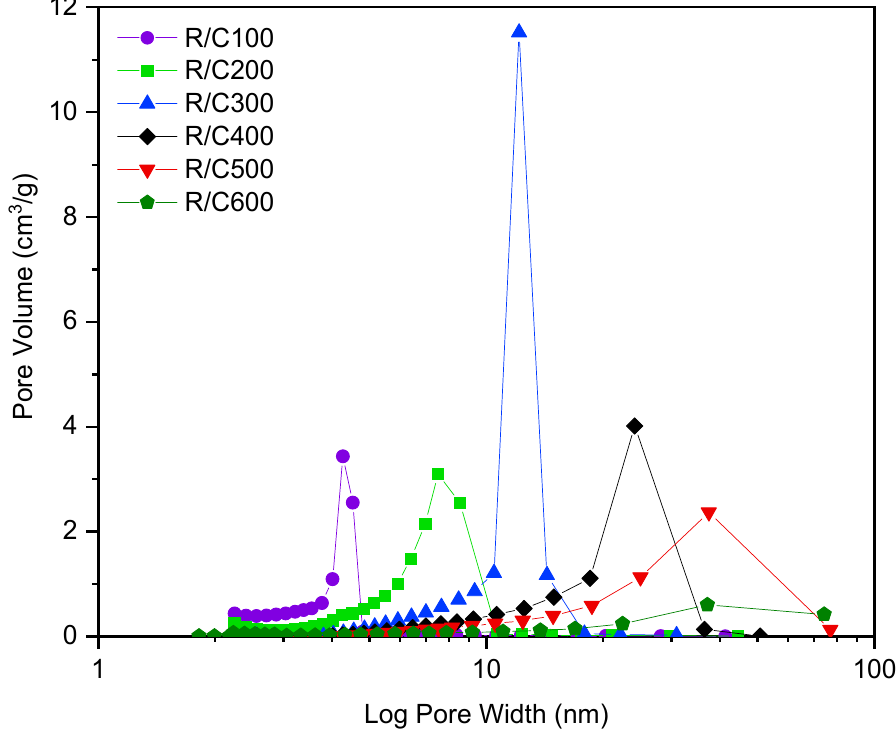
Figure 3. Pore size distributions for sodium carbonate gels at resorcinol/catalyst molar ratios (R/C ratios) 100–600.